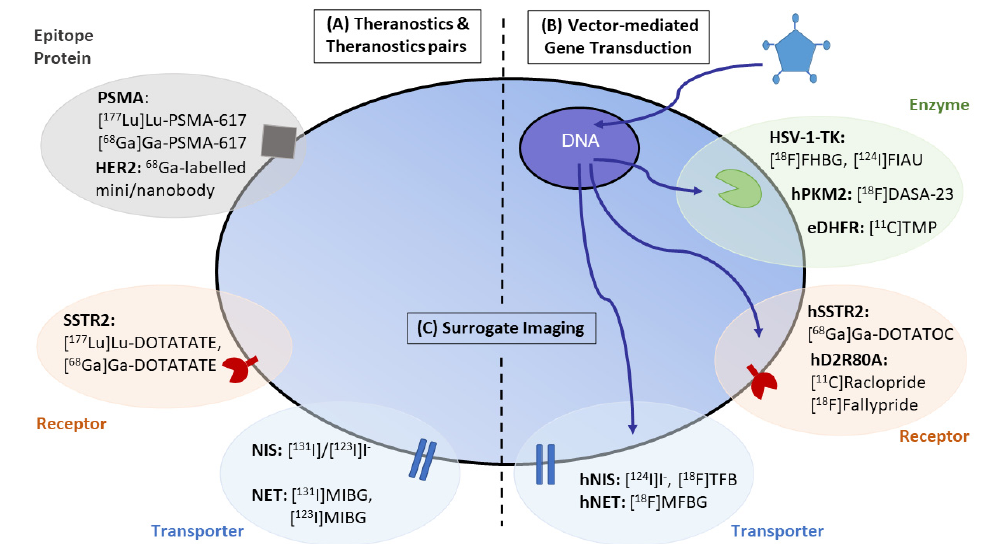
Figure 1. Overview of theranostic applications in oncology. ( A ) Theranostic applications in oncology have gained importance in the management of remnant tumors using cancer ‐ type specific biomarkers, including SSTR2 ‐ positive or NET ‐ positive neuroendocrine tumors, NIS ‐ positive differentiated thyroid tumors and PSMA ‐ positive prostate cancer. ( B ) The combination of vector ‐ mediated gene transduction with the corresponding PET/SPECT ‐ CT imaging probe not only benefits tracking of the efficiency of gene transduction but also establishes the fundamental principles to enlarge the field of theranostic applications by inducing the expression of an enzyme, receptor or transporter targeted by the corresponding theranostic radiopharmaceuticals. ( C ) Surrogate imaging relies on the visualization by molecular imaging of the downstream effects (metabolism, proliferation, associated inflammation) of a gene or cell ‐ based therapy paradigm. Image modified from Jacobs et al. (2021) [6].